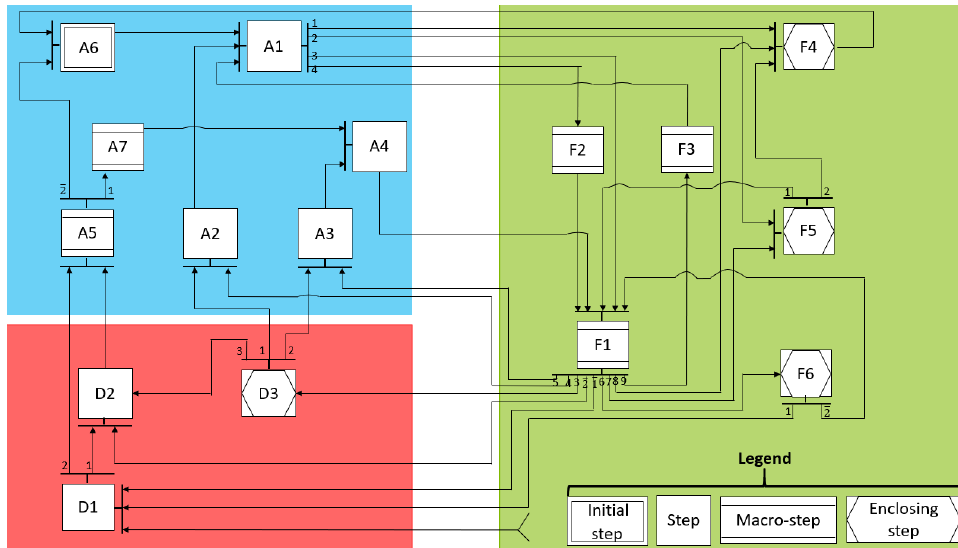
Figure 1. GRAFCET model of the GEMMA